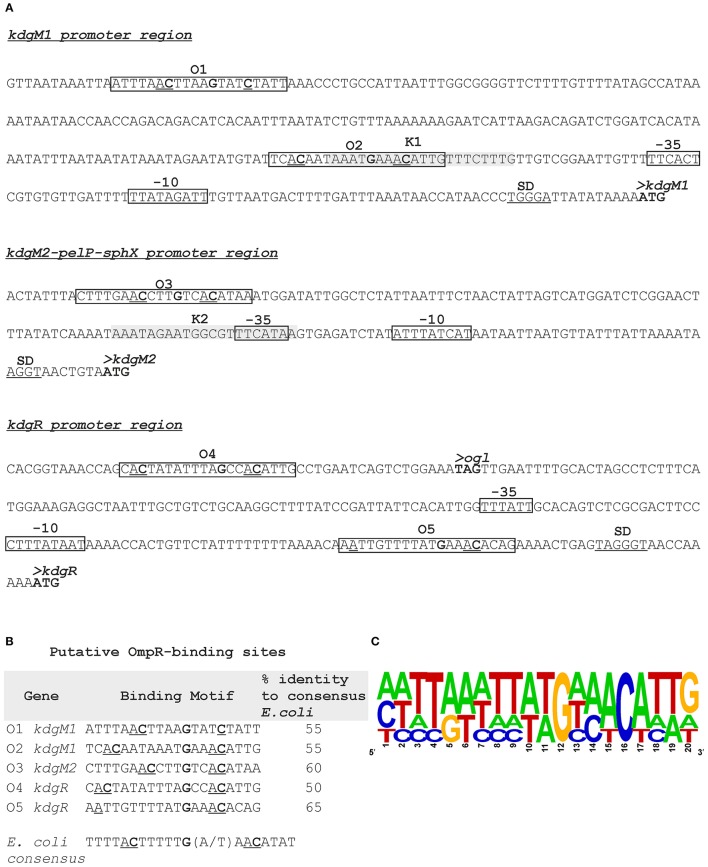
Putative OmpR-binding sites in the promoter regions of the kdgM1, kdgM2-pelP-sghX and kdgR genes of Y. enterocolitica. (A) The boxes indicate putative −35 and −10 promoter elements. The SD sequence is underlined. The start codon (ATG) of each gene is shown in bold. Putative OmpR binding sites identified by in silico analysis (O1-O5) are boxed. Potential binding sites for KdgR (K1, K2) are shaded gray. (B) Sequences of putative OmpR-binding sites in the promoters of the indicated Y. enterocolitica genes determined based on similarity to the E. coli consensus sequence (% identity values are shown). The central motif GXXAC or GXXXC and the AC or C nucleotides usually located about 10 nt away from the AC elements of the central motif are marked. (C) Logo motif (alignment) of putative OmpR-binding sites identified in the Y. enterocolitica kdgM1, kdgM2-pelP-sghX and kdgR regulatory regions. WebLogo (http://weblogo.berkeley.edu/logo.cgi) was used to obtain consensus sequence logos in which the height of individual letters represents the relative frequency of that particular nucleotide at a given position, and the number of letters in each stack indicates the degree of conservation at that position.